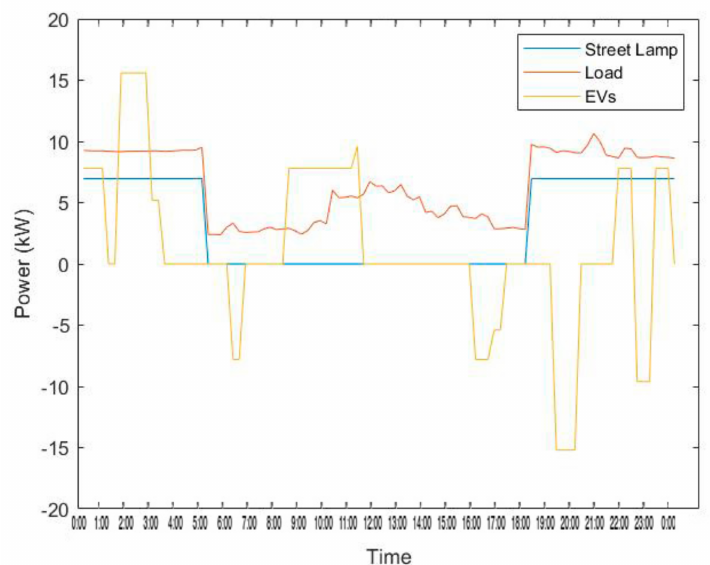
Figure 9. Total electricity consumption by houses, streetlamps and EVs (Cloudy Day).